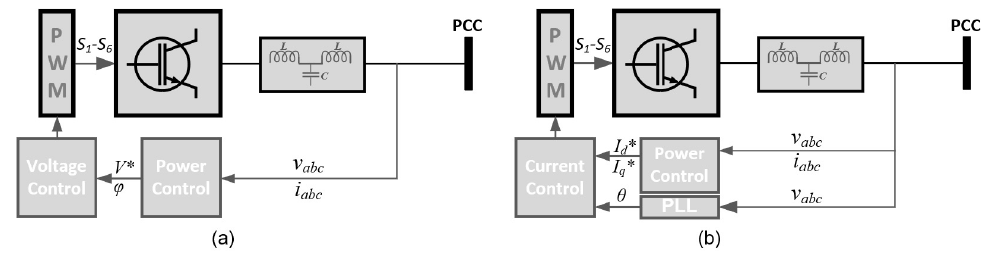
Figure 19. Two main PEC topologies: ( a ) GFM converter, ( b ) GFL